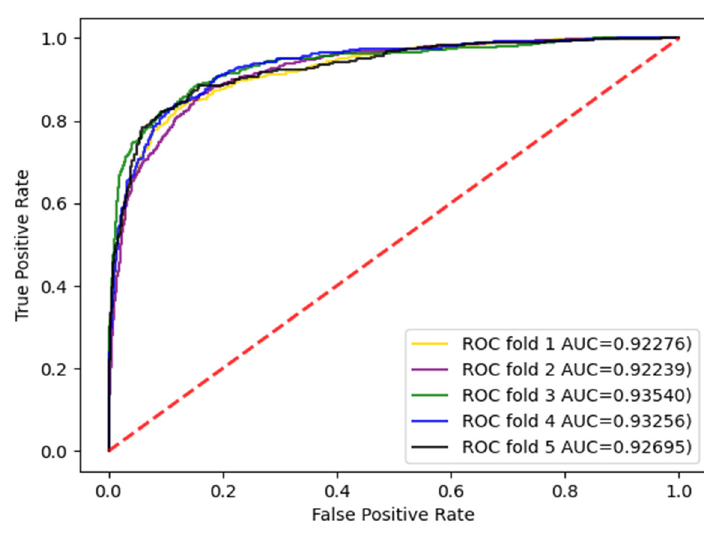
Figure 4. AUC curve of the enzyme dataset under CVP division.